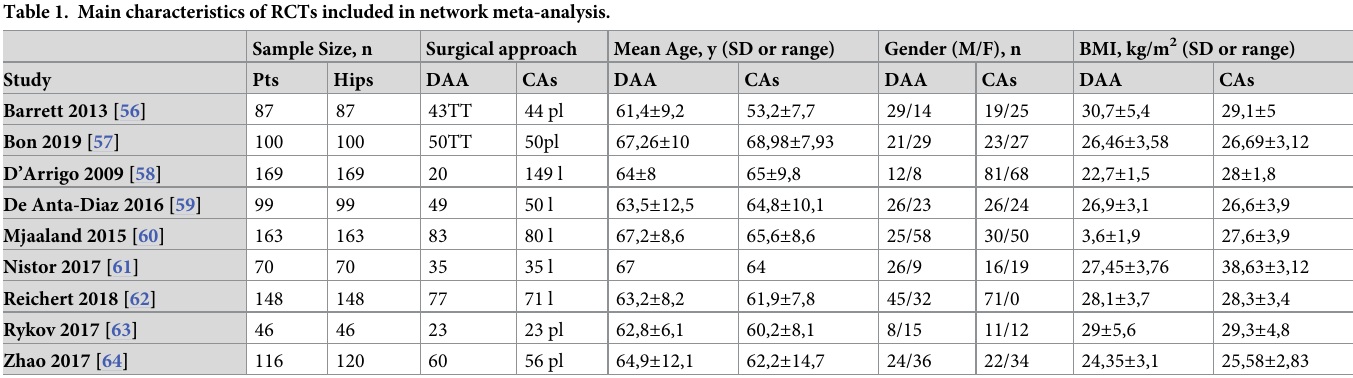
Table 1. Main characteristics of RCTs included in network meta-analysis. Sample Size, n Surgical approach Mean Age, y (SD or range) Gender (M/F), n BMI, kg/m 2 (SD or range)